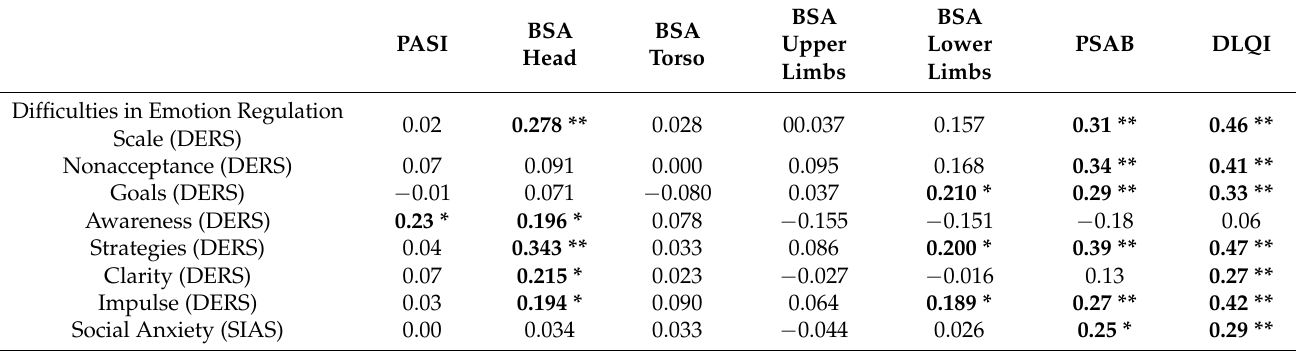
Table 2. Correlations between clinical variables with emotional dysregulation traits and social anxiety in patients with mild psoriasis ( n =